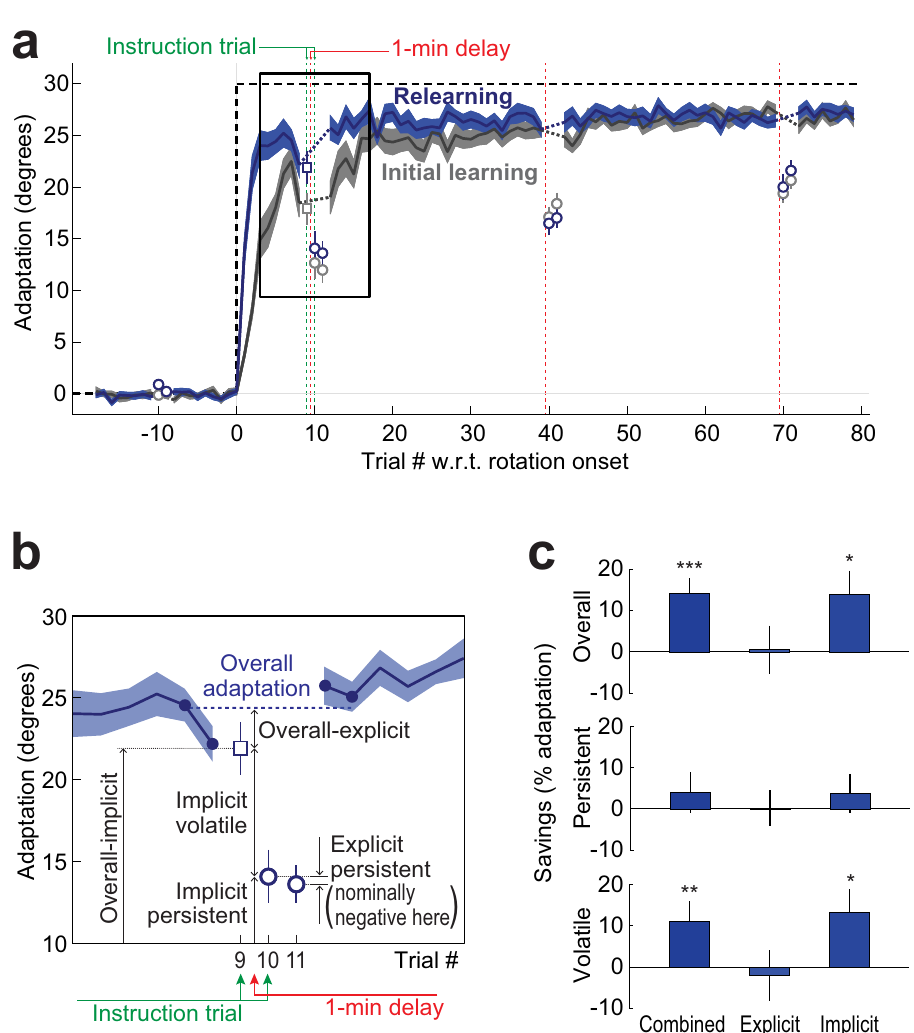
Fig 4. Temporally-volatile savings are due to an implicit adaptation component. (a) Learning curves for Experiment 3, showing overall adaptation (solid lines), overall implicit adaptation (square) and persistent adaptation (circles). Gray denotes initial learning, blue denotes relearning. Shading indicates SEM. (b) Diagram illustrating measurements of specific components of implicit and explicit learning for Experiment 3, based on a zoomed-in view of the blue retraining data from panel a . Instructions 1 trial before and 1 trial after the 1-min delay (trials 9 and 10) allow the direct measurement of overall-implicit and implicit-persistent components, respectively. This allows measurement of implicit-volatile as the difference between them, and overall-explicit adaptation as the difference between overall adaptation and overall-implicit, where overall adaptation is measured as the average amount of adaptation 2 trials before the first instruction trial and 2 trials after the last persistent-only trial (i.e., trials 7, 8, 12, and 13; blue filled circles). Both instruction trials have no visual feedback to avoid per-trial learning leading to posttrial recovery of adaptation. The following trial (trial 11) thus allows direct measurement of combined implicit and explicit persistent adaptation, therefore, the difference between trial 11 and trial 10 measures explicit-persistent. Trial 11 also reintroduces visual feedback, allowing adaptation to recover by the next trial. (c) Savings in overall, temporally- persistent, and temporally-volatile adaptation in Experiment 3, both for combined implicit and explicit adaptation (left column) and broken into implicit and explicit components. In line with Experiments 1 and 2, data show overall and volatile, but not persistent, savings for combined (implicit + explicit) adaptation. Further dissociation into implicit and explicit components reveals this savings is due to implicit, temporally-volatile adaptation. Error bars indicate SEM. * p < 0.05; ** p < 0.01. Underlying data supporting this figure can be found in file